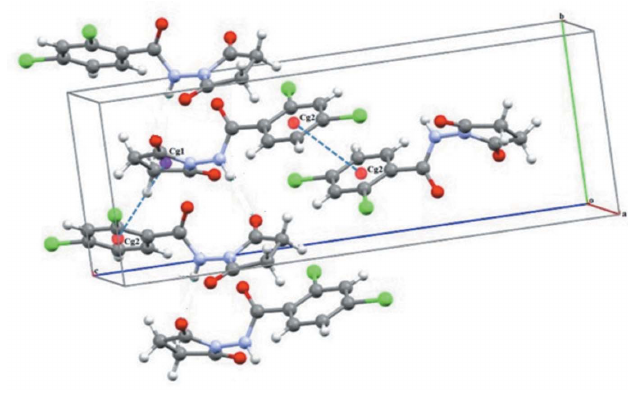
Figure 2 Part of the crystal structure showing N—H (cid:3)(cid:3)(cid:3) O hydrogen bonds as dashed lines.